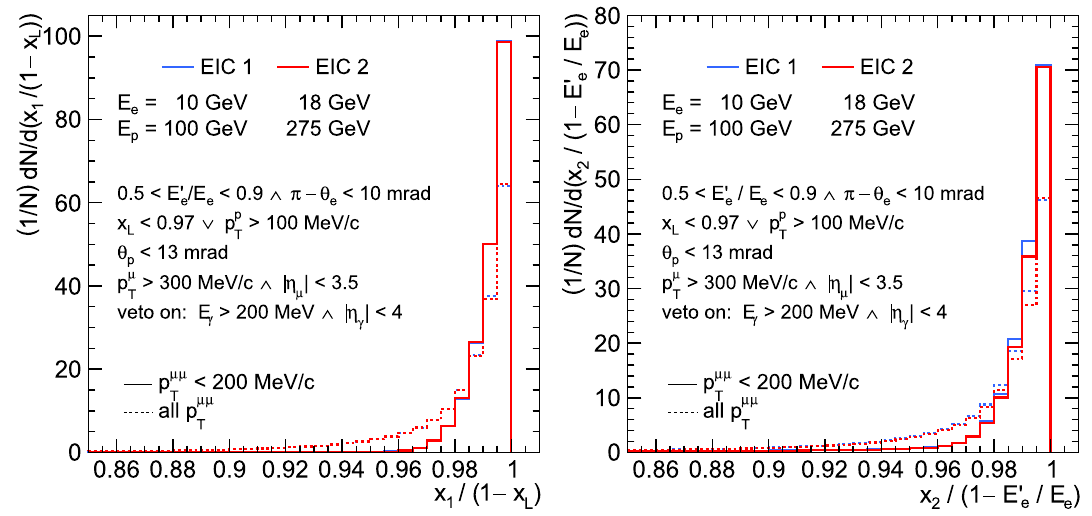
Fig. 2 Correlation of the lepton pair transverse momentum, p EIC. The photon veto (2.4) was applied